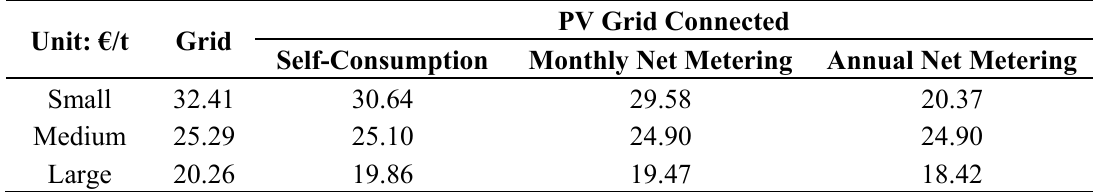
Table 12. Energy price per tonne of olive oil produced (year